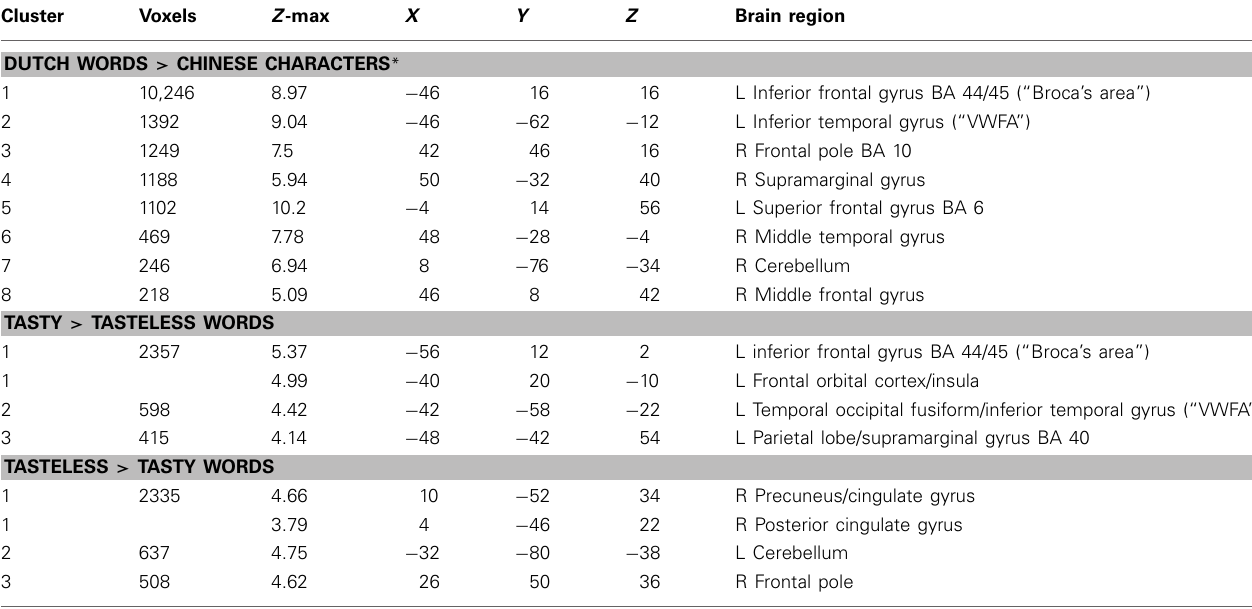
Table 4 | Significant clusters of fMRI activation in SC related to written language for the contrasts (A) Dutch words > Chinese characters, (B) tasty > tasteless words , and (C) tasteless > tasty words . Cluster Voxels Z -max X Y